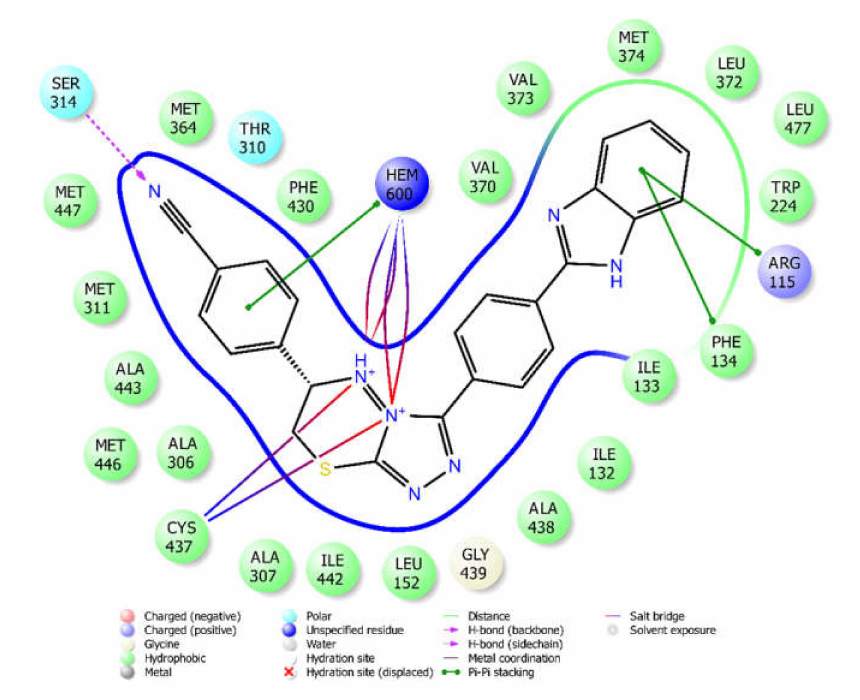
Figure 1. Two-dimensional interaction mode of compound 5e in the enzyme active site (Human aromatase PDB Code: